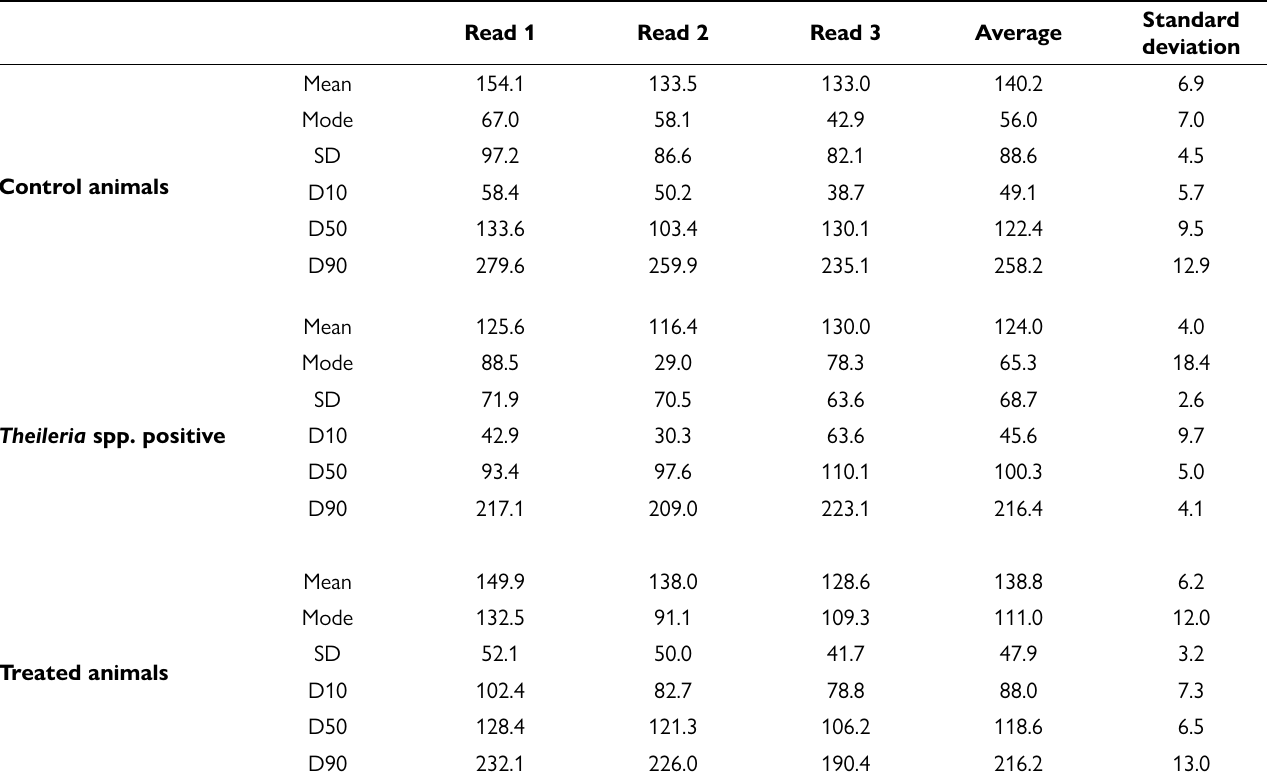
Table 1. Nanoparticle tracking analysis of extracellular vesicles obtained from Bubalus bubalis sera found in F3 fractions isolated from control animals, Theileria spp. positive animals and treated animals (± standard error). Values are represented in nanometers